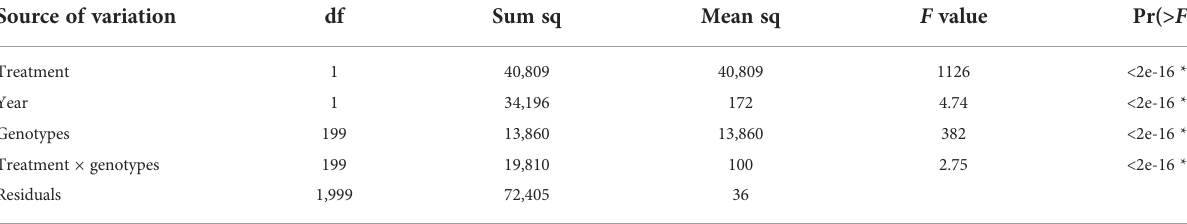
TABLE 1 Analysis of variance (ANOVA) of pollen viability during 2020 – 2021 and 2021 – 2022. Source of variation df Sum sq